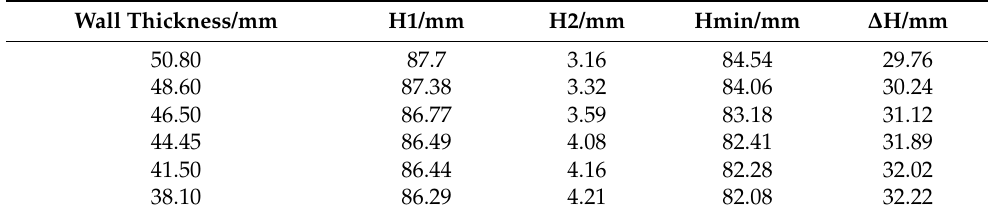
Table 1. Diameter parameters under different cement sheath wall thicknesses.